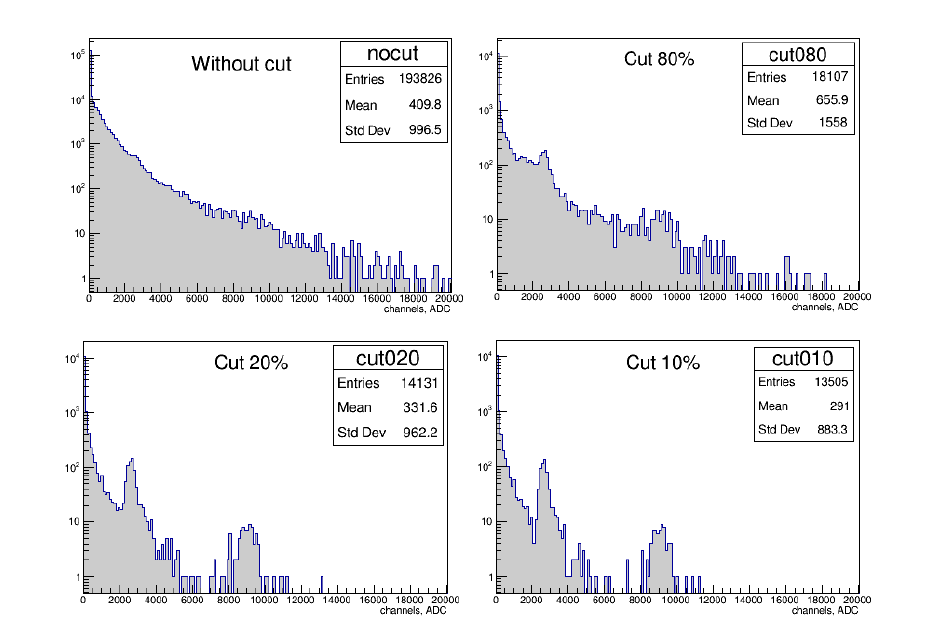
Figure 1. Di ff erent cut on energy in 9 calorimeter cells